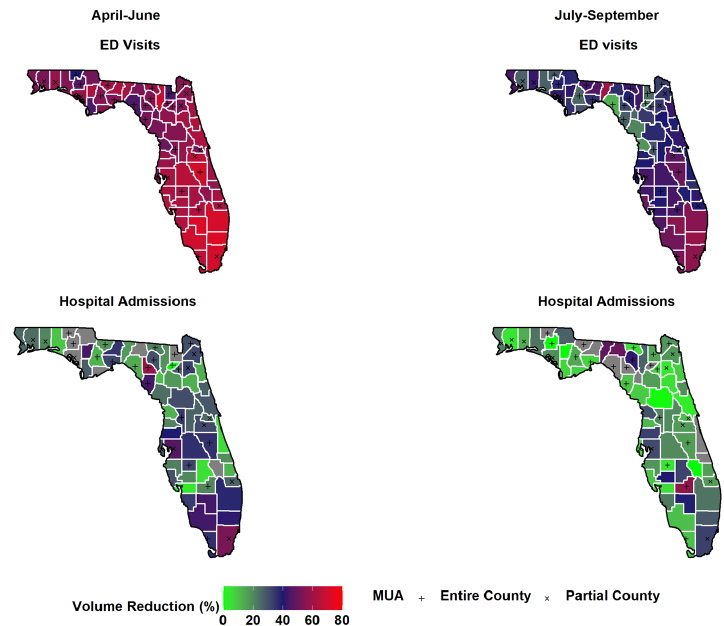
Figure 1. Changes in pediatric hospital visits during COVID-19 pandemic across Florida counties (MUA—Medically underserved Area, ED—Emergency Department).